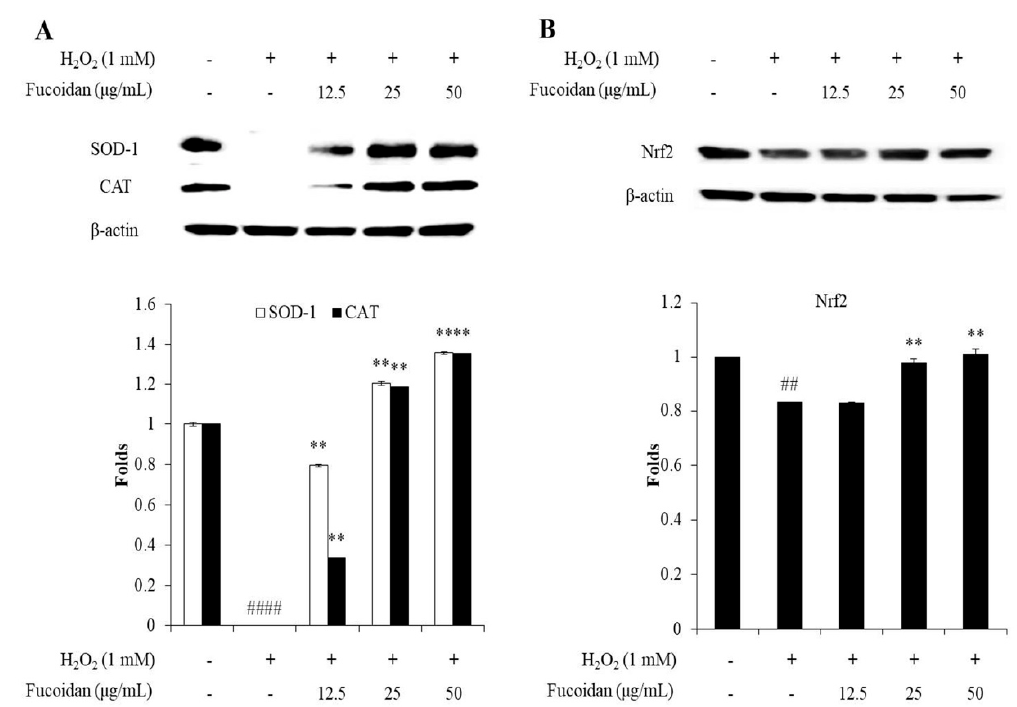
Figure 4. The effect of fucoidan on nuclear factor (erythroid-derived 2)-like 2 (Nrf2) pathway and antioxidant enzymes expression in H 2 O 2 -stimulated Vero cells. ( A ) The expression of catalase (CAT) and superoxide dismutase-1 (SOD-1); ( B ) the expression of Nrf2. The amount of CAT, SOD-1, and Nrf2 were compared with β -actin. “ + ”: treatment; “-“: non-treatment. The experiments were conducted in triplicate, and the data are expressed as the mean ± SE. * p < 0.05, ** p < 0.01 as compared to the H 2 O 2 -treated group and ## p < 0.01 as compared to the control group.